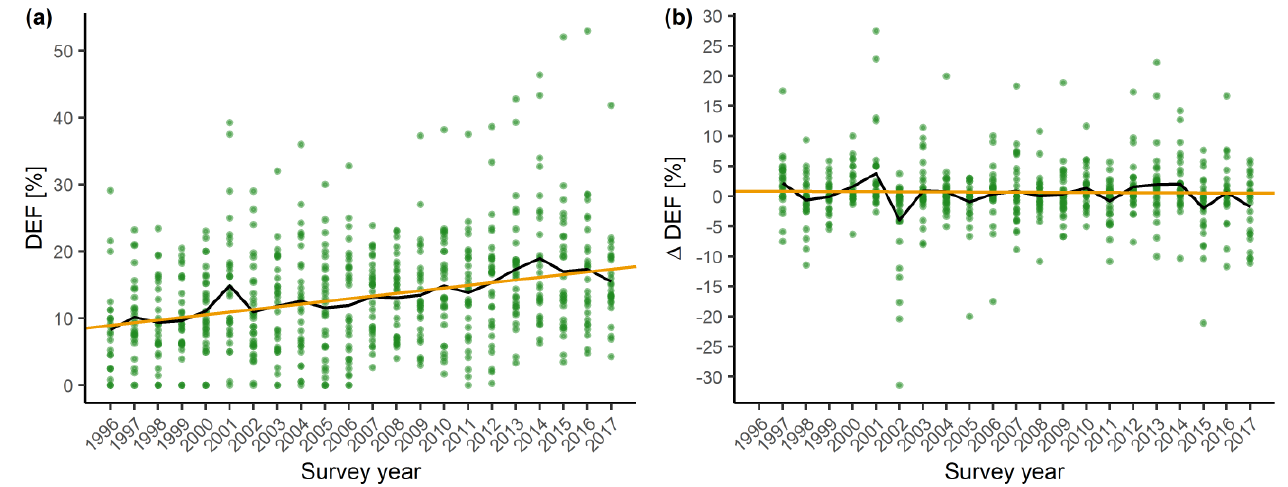
Figure 1. Overall trend of crown vitality parameters from 1996–2017. ( a ) Defoliation trend of European beech (Tau = 0.78, Sen’s slope = 0.39, p < 0.001, orange line) and annual overall mean defoliation (DEF i , black line). ( b ) Defoliation change trend of European beech (Tau = −0.05, Sen’s slope = −0.01, p = 0.73, orange line) and annual overall change in mean defoliation (ΔDEF i , black line). Points represent annual plot mean values.